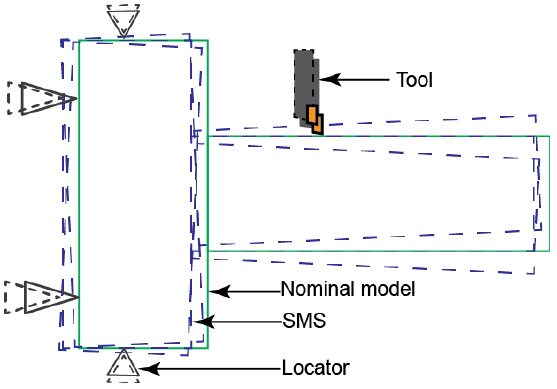
Figure 7. Illustration of locator deviations and possible effects on a model, along with tooltip deviation.